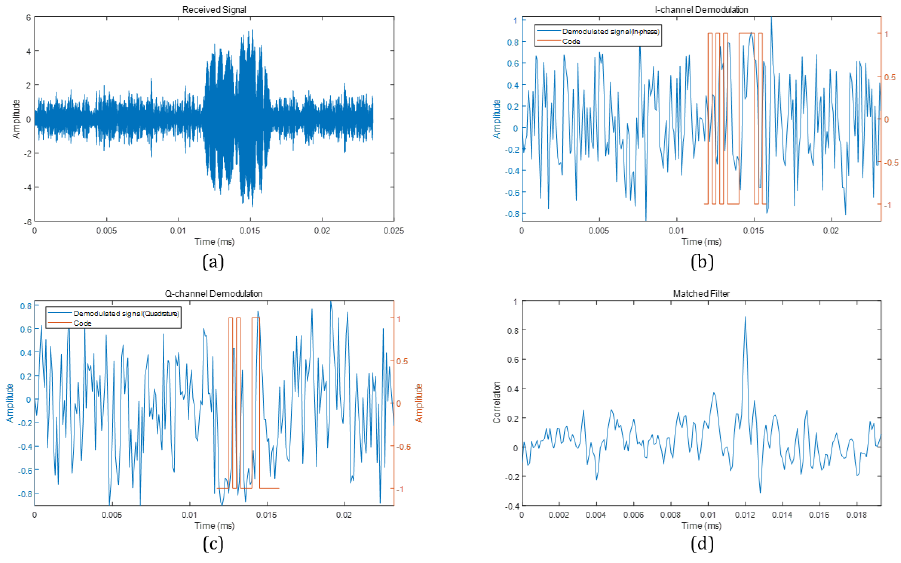
Figure 5. ID detection process. ( a ) Received signal; ( b ) Demodulated signal (In-phase); ( c ) Demodulated signal (Quadrature); ( d ) Matched filter.